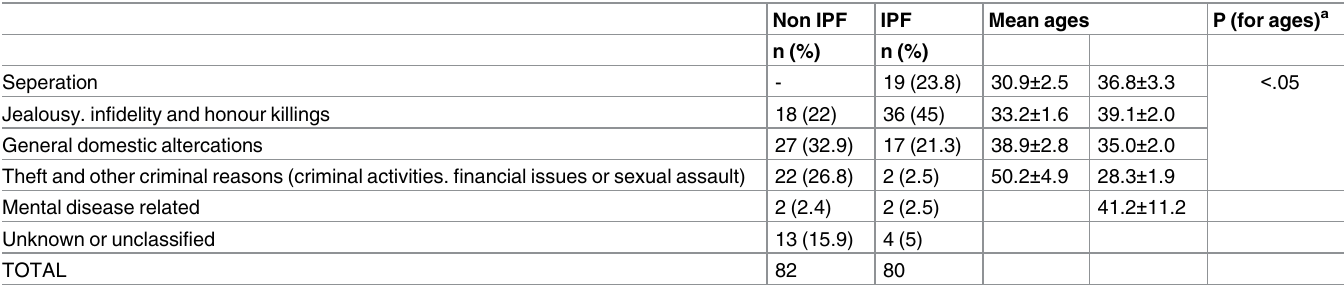
Table 5. Motives and mean ages of victims and perpetrators.